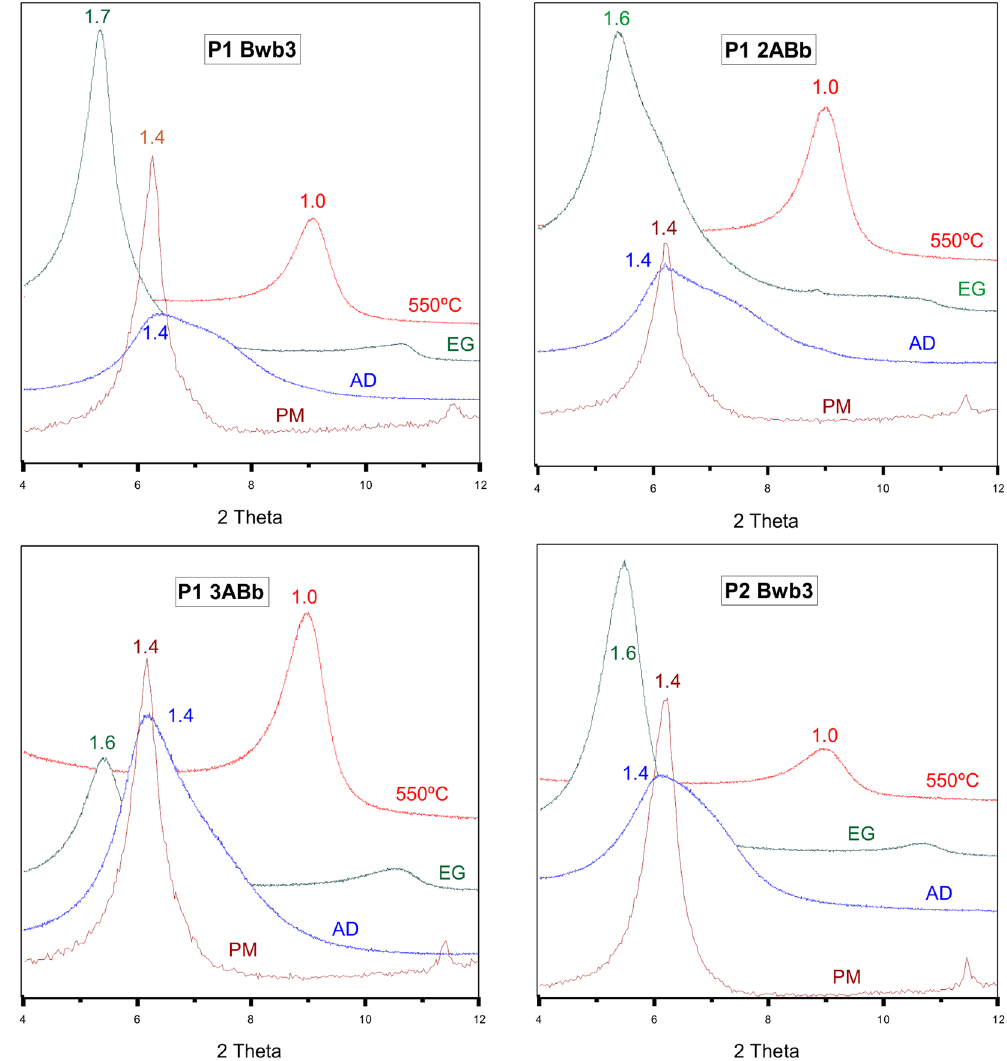
Figure 5. XRD patterns of clay samples from selected horizons. The d-spacing are given in nm. AD = Air dried, EG = Ethylene glycol solvation, 550 °C = sample heated at 550 °C, PM = parent